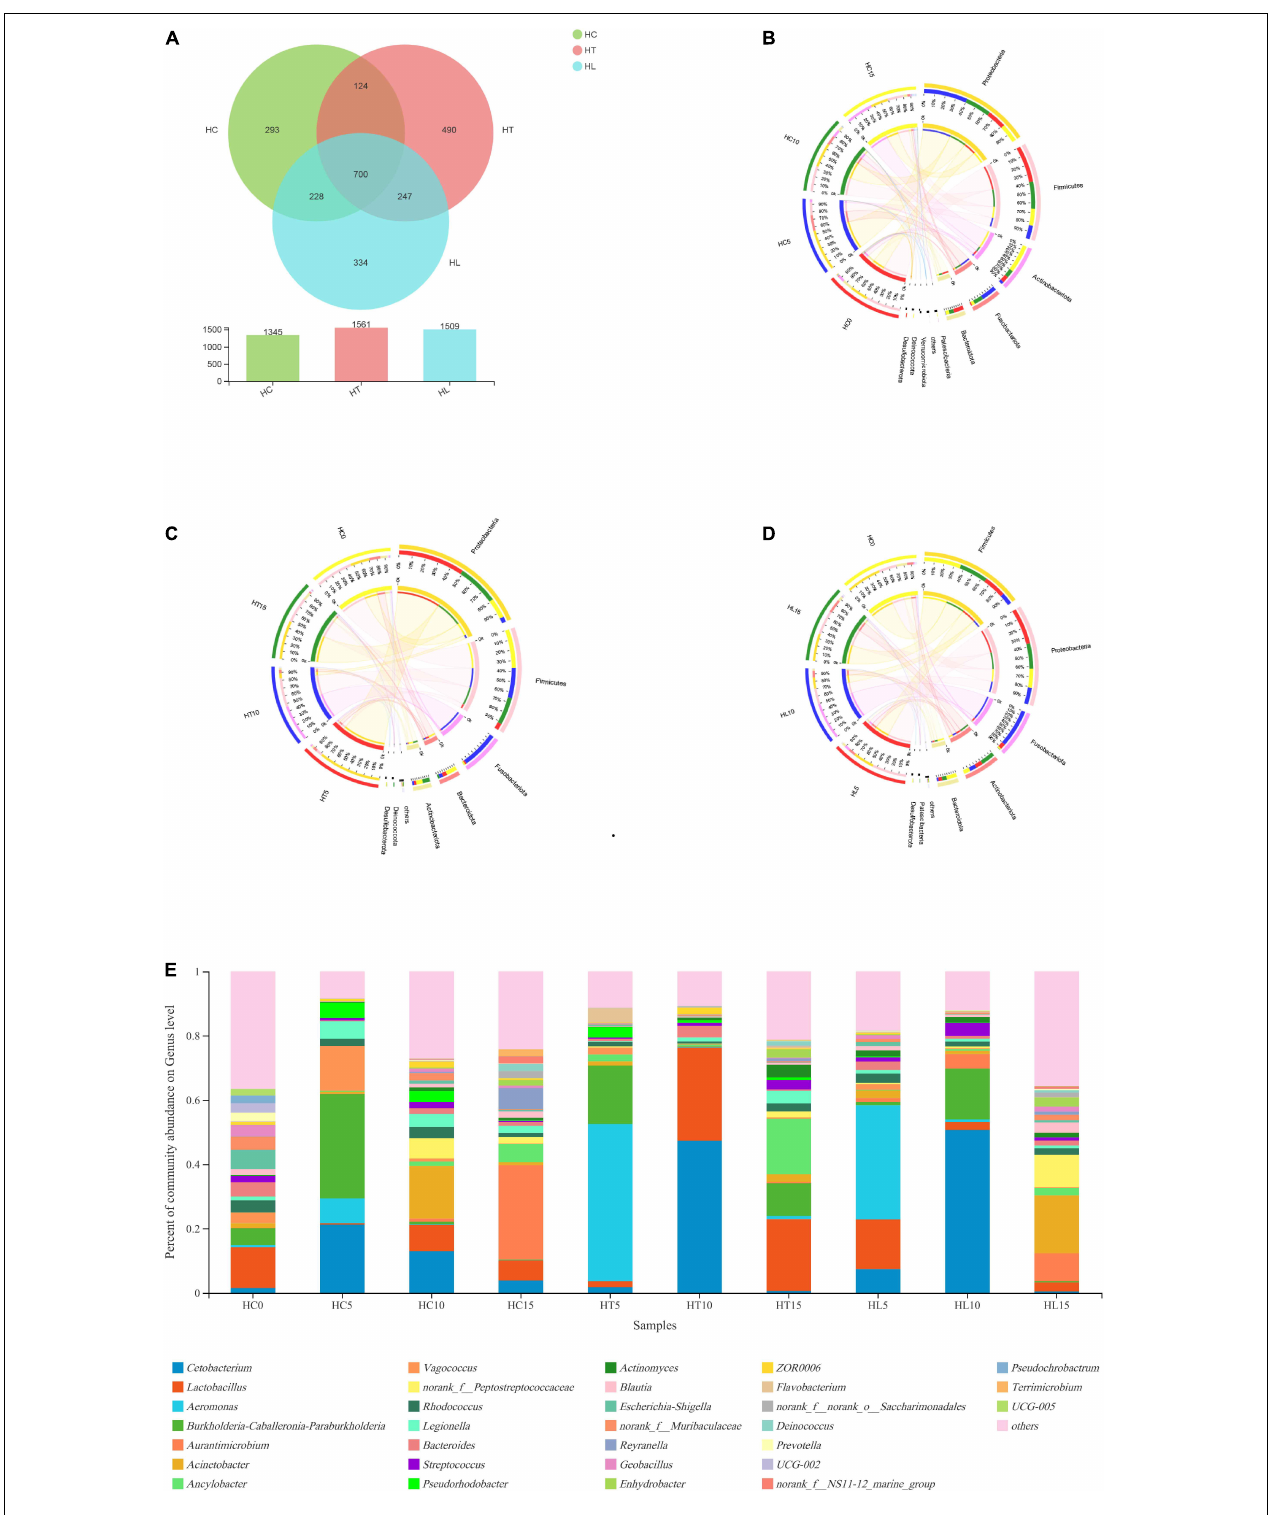
FIGURE 1 | Beta diversities of intestinal bacterial community composition of crucian carp ( Carassius auratus ). (A) A Venn diagram showing bacterial numbers shared within and between sample groups. A circos plot at the phylum levels shows the linkage among (B) the control group (HC), (C) the L. lactis 1,209 treatment group (HT), and (D) the L. lactis 1,242 treatment group (HL), with 10 6 CFU/mL L. lactis 1,242. (E) Bacterial community and relative abundance at the genus levels for all crucians. Taxa with an abundance < 2% are included in “others.” HC: The control group, HT: The L. lactis 1,209 treatment group, HL: The L. lactis 1,242 treatment